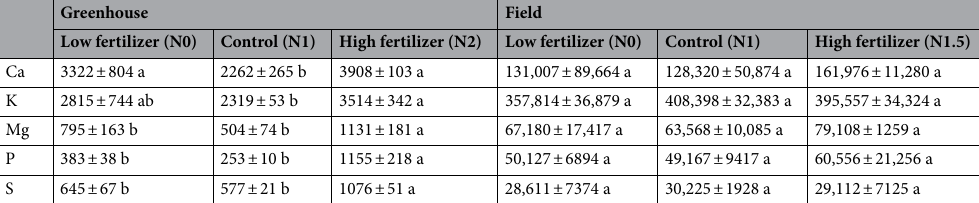
Table 3. Nutrient concentrations of pepper leaves treated with different urea fertilizer applications (mg/kg). Significant differences among different treatment groups were marked with different letters ( p < 0.05).